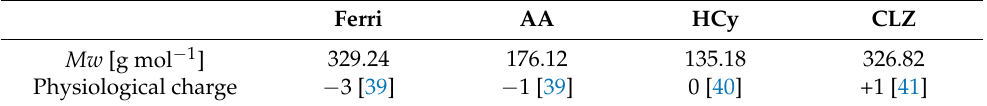
Table 1. Molecular weight and the physiological charge properties of the tested redox-active molecules.